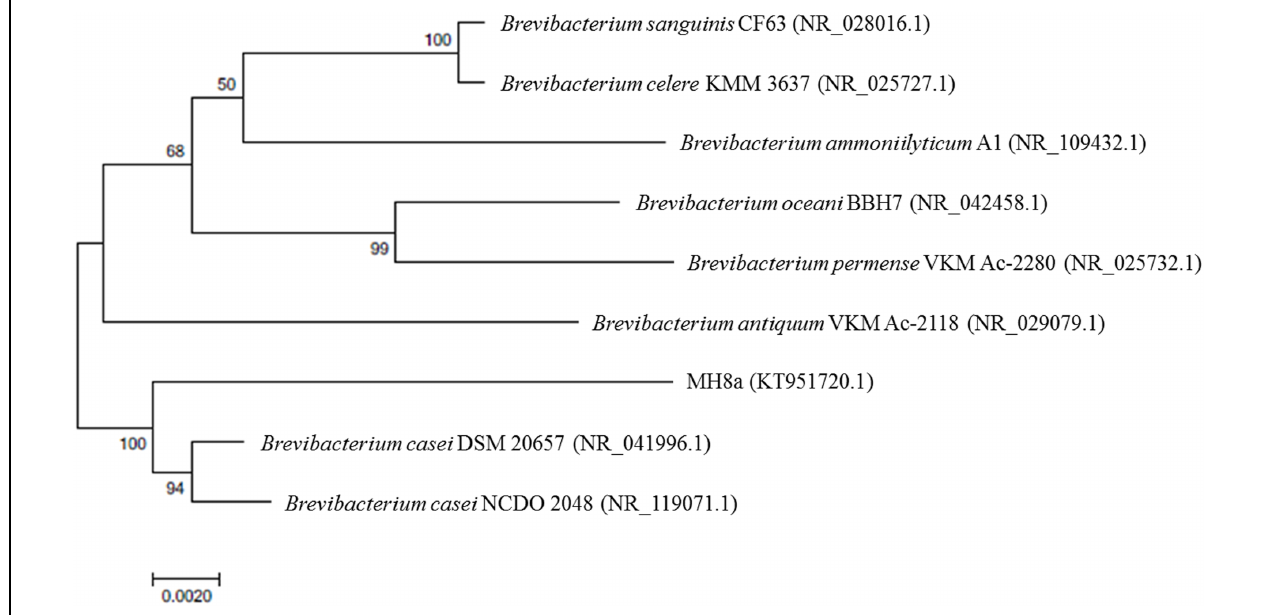
FIGURE 1 | Neighbor–joining phylogenetic tree of bacteria based on a comparison of 16S rRNA gene sequence. Bootstrap values are indicated at the branches from 1,000 replications. GenBank accession numbers are given in brackets.